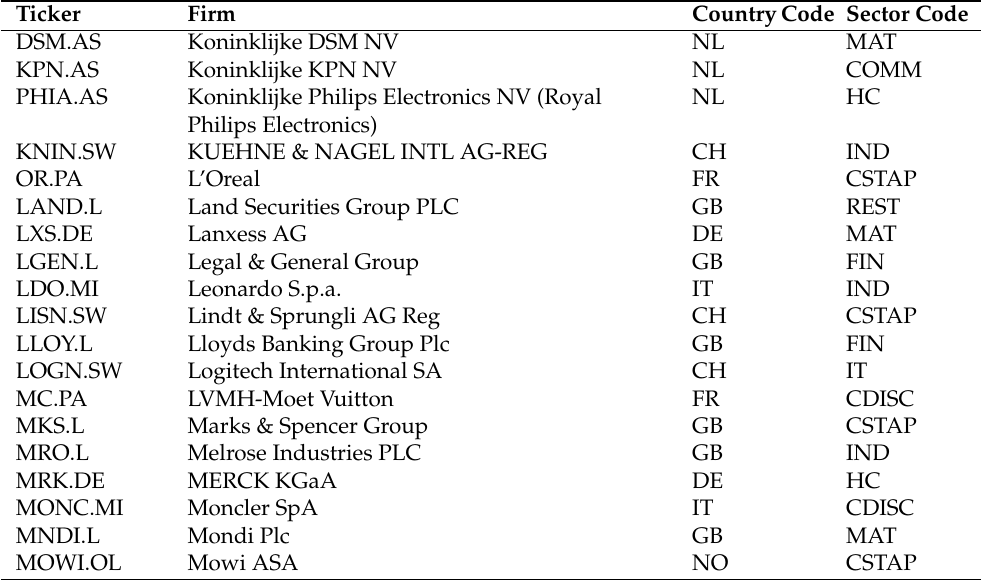
Table A7. Part IV. Ticker Firm